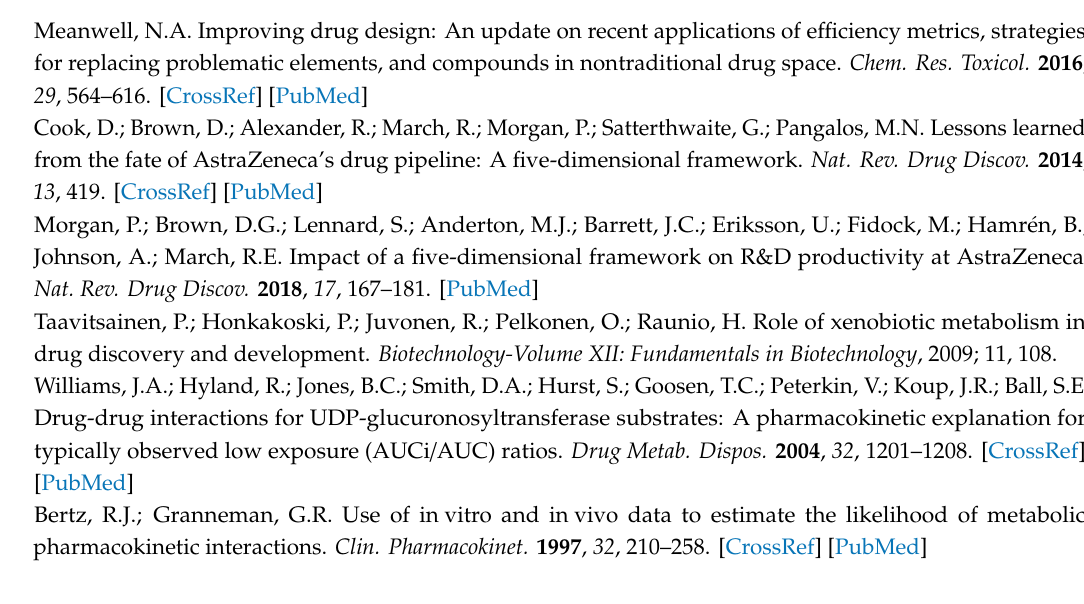
Table S1: LipE and LE profiling results of CYP1A2 inhibitors dataset, Table S2: LipE and LE profiling results of CYP2C9 inhibitors dataset, Table S3: LipE and LE profiling results of CYP2C19 inhibitors dataset, Table S4: LipE and LE profiling results of CYP2D6 inhibitors dataset and Table S5: LipE and LE profiling results of CYP3A4 inhibitors